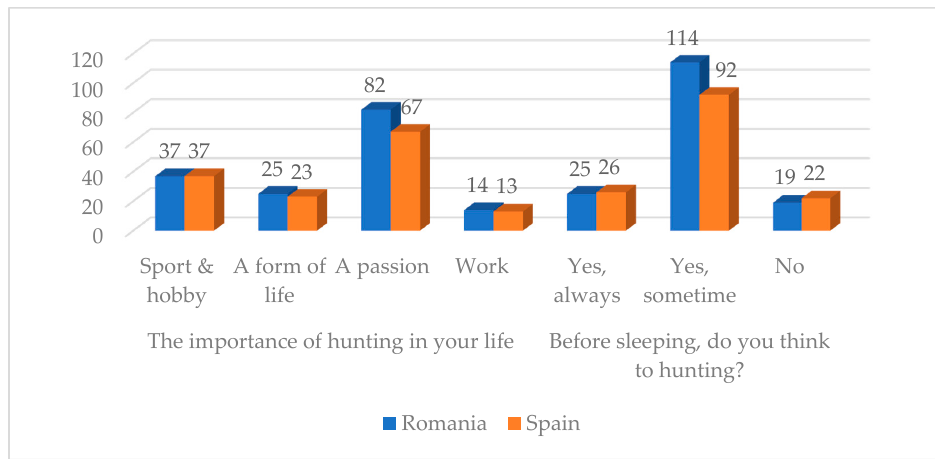
Figure 4. Distribution of the answers for two questions regarding the hunting data. The distribution and structure of the Romanian and Spanish hunters together with the questions can be observed comparatively in Table 3. Table 3. The distribution and structure of answers for other hunting data.